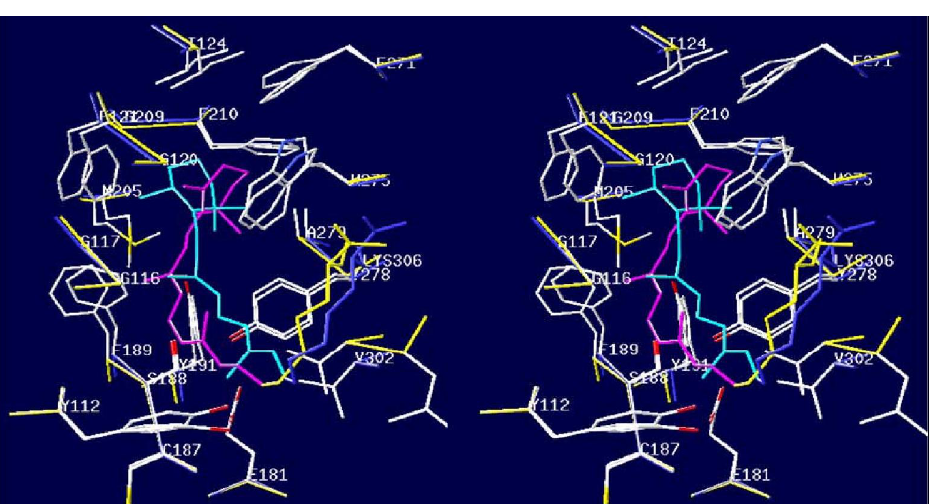
Figure 7. Above: Stereo view of the superimposed retinal-binding pocket for 11-cis (left) and all-trans (right) retinal. The retinal is colored in magenta and cyan respectively; backbone atoms in yellow and blue, respectively, and sidechain atoms according to the CPK scheme. Below: SDS-Page of rhodopsin protein after purification step: rhodopsin concentrated samples were run on lanes 1, 2, 3, 4 and molecular weight markers were run on lane M. Molecular weight of rhodopsin thus determined was ~33